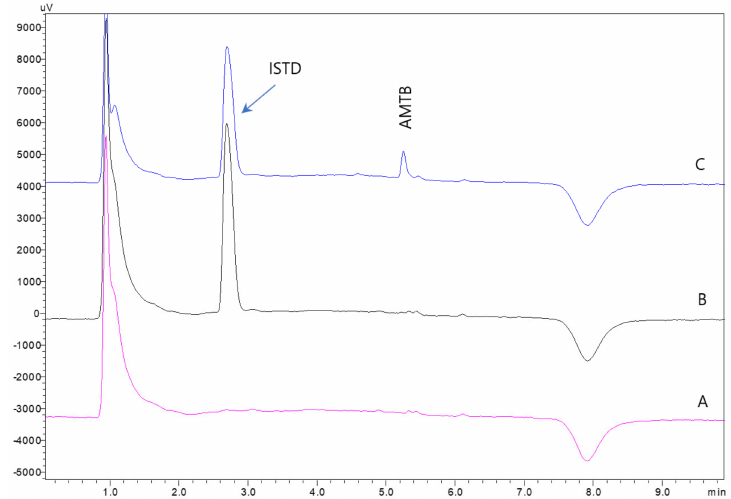
Figure 3. Representative chromatogram of the FPSE-HPLC-UV analysis of (A) blank human urine sample, (B) spiked with ISTD solution and (C) spiked with ISTD and AMTB at 1.0 µ g mL − 1 .